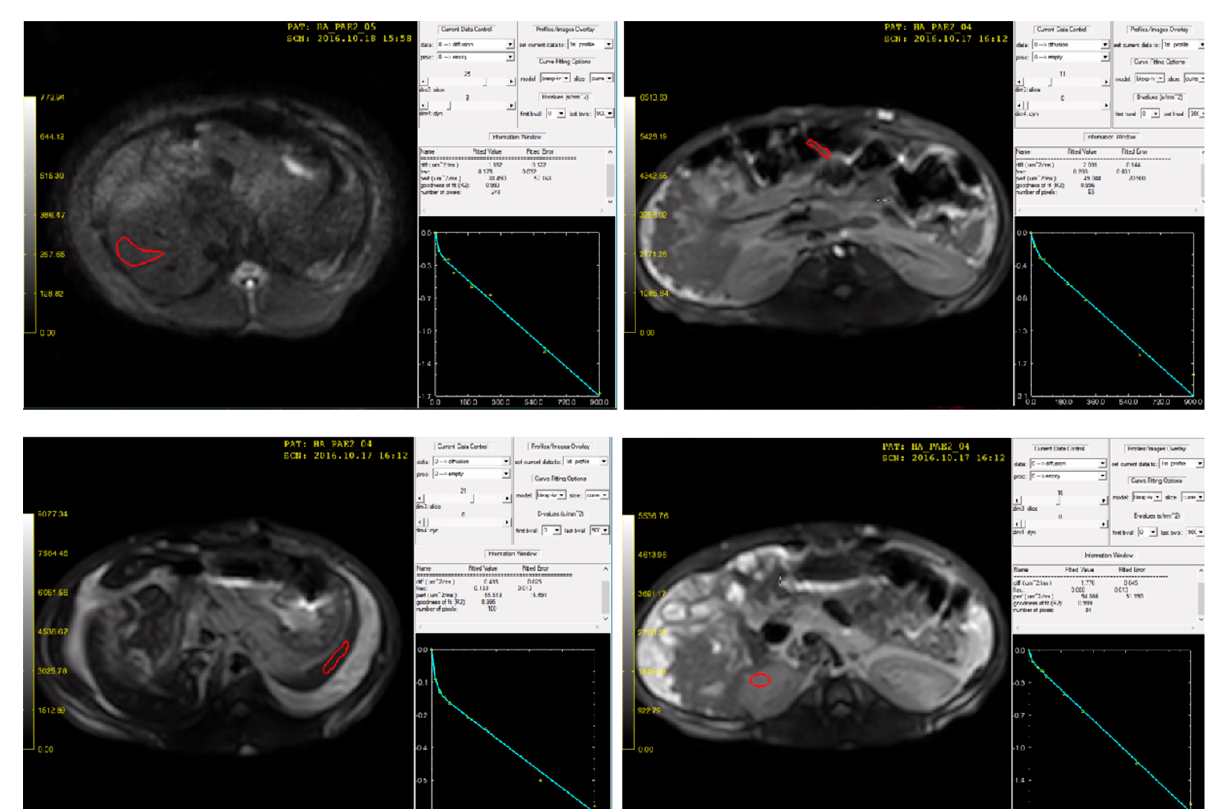
Figure 1. The ROIs drawing process using the software Pride R1.5. From upper left (clockwise): liver ROI (red), intestine ROI, left kidney ROI and spleen ROI. For every quadrant, on the down right corner the graph for the calculation of the goodness of fit. In the illustration, T2-weighted images, where the ROIs were drawn.